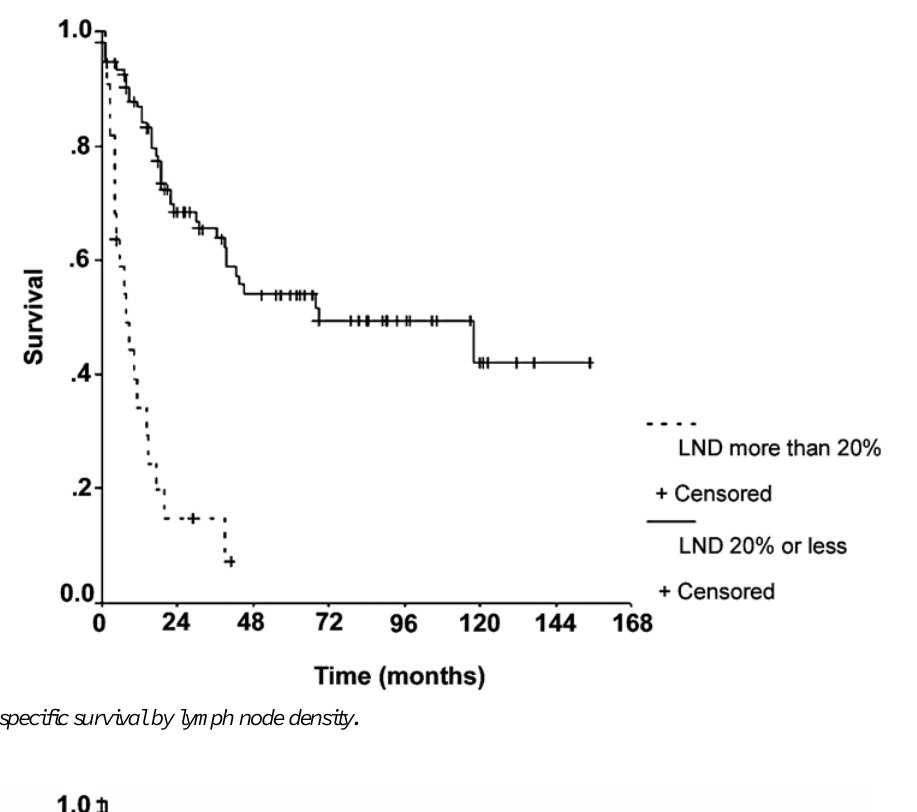
Figure 4 – Disease specific survival by lymph node density.